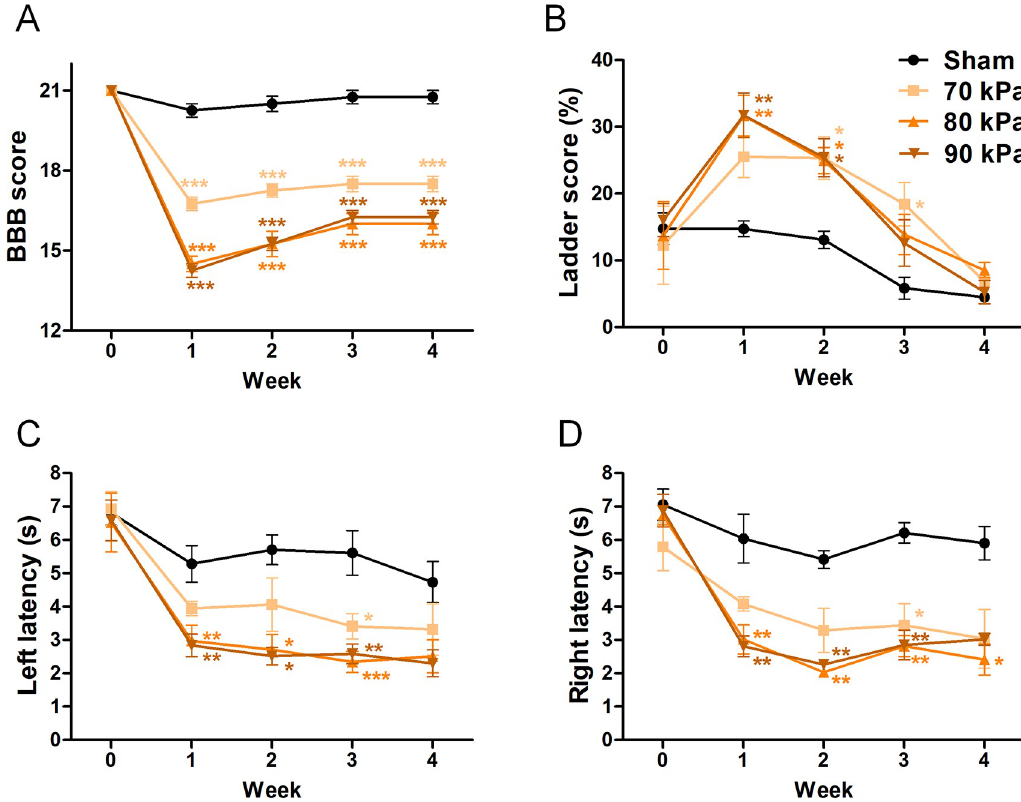
Fig 5. Functional assessment of the LSS model. (A) Basso, Beattie, and Bresnahan (BBB) score, (B) ladder score, and (C, D) Von Frey test (n = 6 per group). Data are expressed as the means ± SEM. � P < 0.05, �� P < 0.01, and ��� P < 0.001 compared with the sham group analyzed by a one-way ANOVA with Tukey’s post-hoc